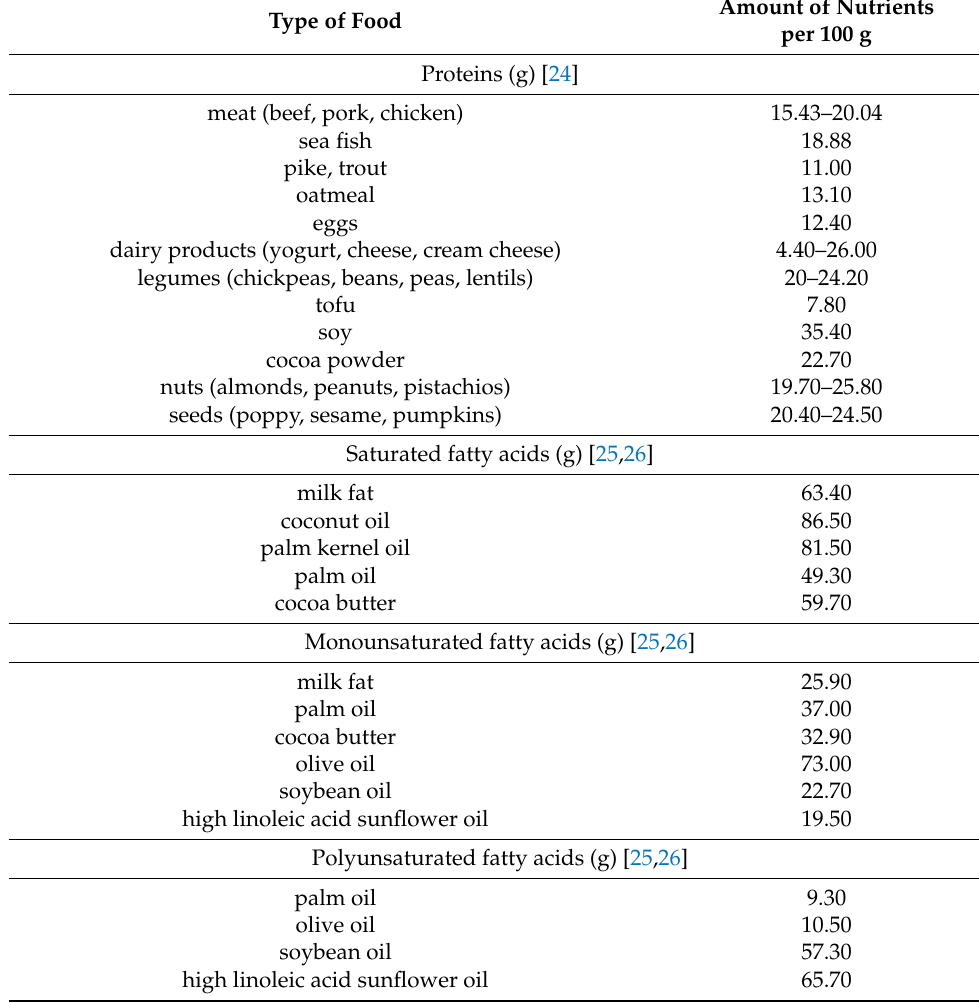
Table 1. The amount of described macronutrients and micronutrients in different types of